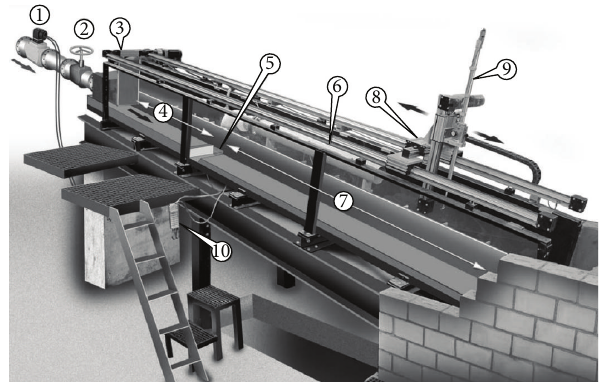
Figure 1: Chute model configuration [7] (with permission from ASCE). (1) flow meter, (2) slide valve, (3) jet-box, (4) approach flow zone, (5) aerator, (6) air duct, (7) measurement range, (8) automatic position system, (9) fiber-optical probe, and (10) cavity